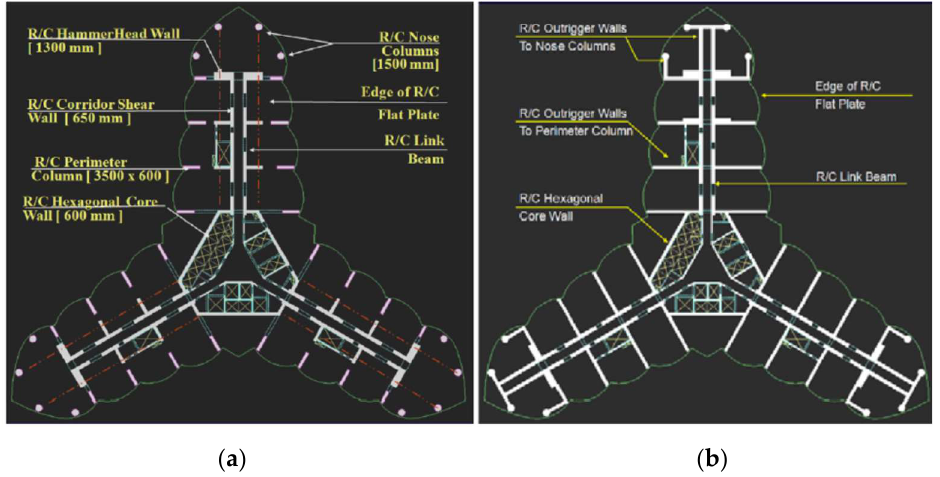
Figure 8. (a) Typical floor framing plans—hotel level; ( b )typical floor framing plans—mechanical Figure 8. ( a ) Typical floor framing plans—hotel level; ( b ) typical floor framing plans—mechanical level.Source: [6].